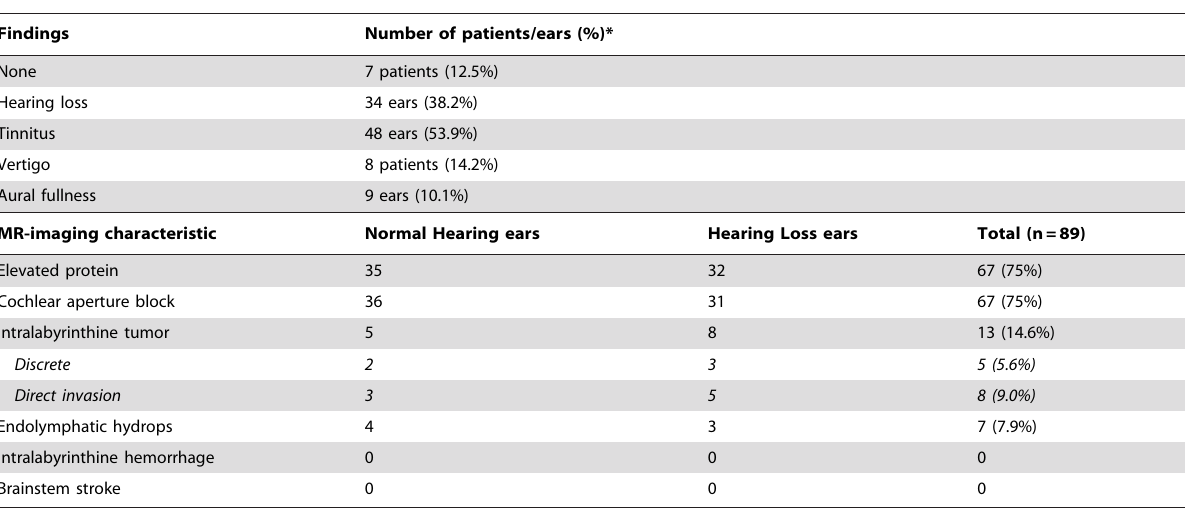
Table 1. Audiovestibular and MR-imaging findings in the 56 study patients (89 ears).